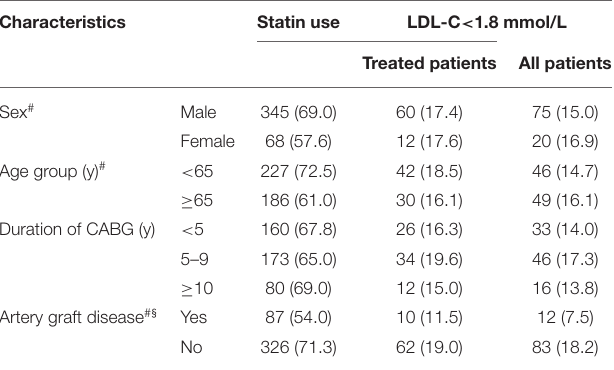
TABLE 4 | Statin use and LDL-C control of the study population.